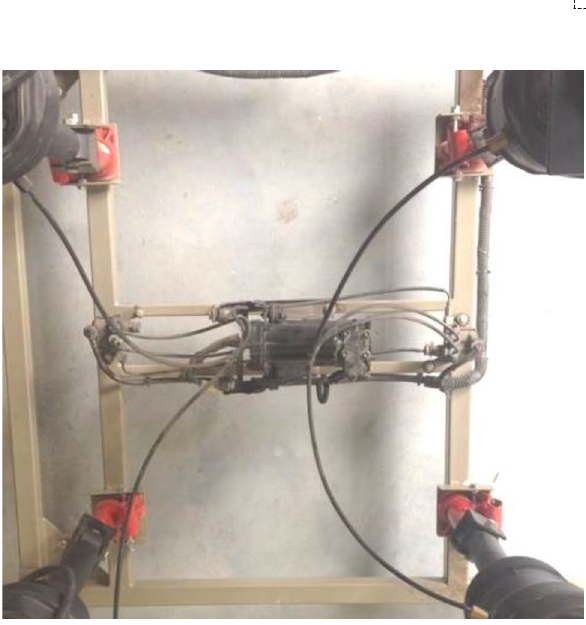
Fig. 3 Adjustment Structure of Stiffness and Damping